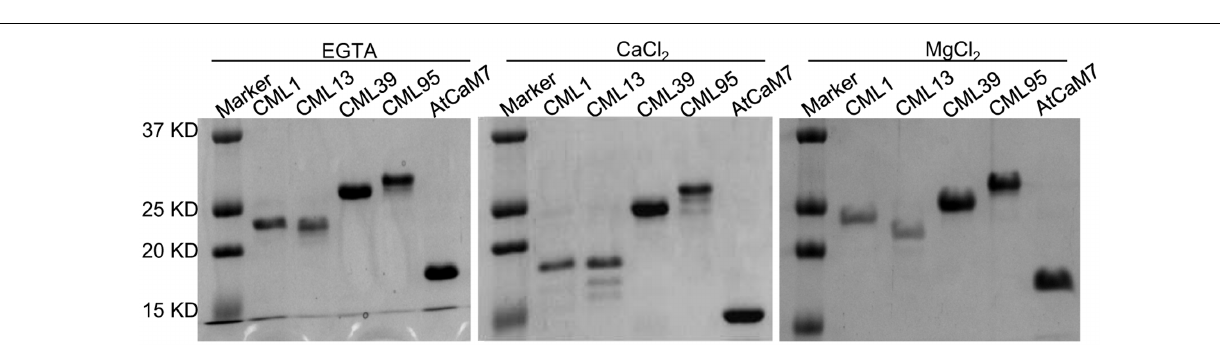
FIGURE 13 | Effect of Ca 2 + on the electrophoretic mobility of GmCML1, GmCML13, GmCML39, and GmCML95 proteins. Samples (1–2 µ g) of purified, recombinant AtCaM7 (positive control), GmCML1, GmCML13, GmCML39, and GmCML95 containing 1.0 mM CaCl2, 1.0 mM EGTA, or 1.0 mM MgCl 2 were separated on SDS–PAGE gels supplemented with 1.0 mM CaCl 2 , 1.0 mM EGTA, or 1.0 mM MgCl 2 , respectively, and stained with Coomassie Brilliant Blue. The positions of the molecular weight markers (kDa) are indicated on the